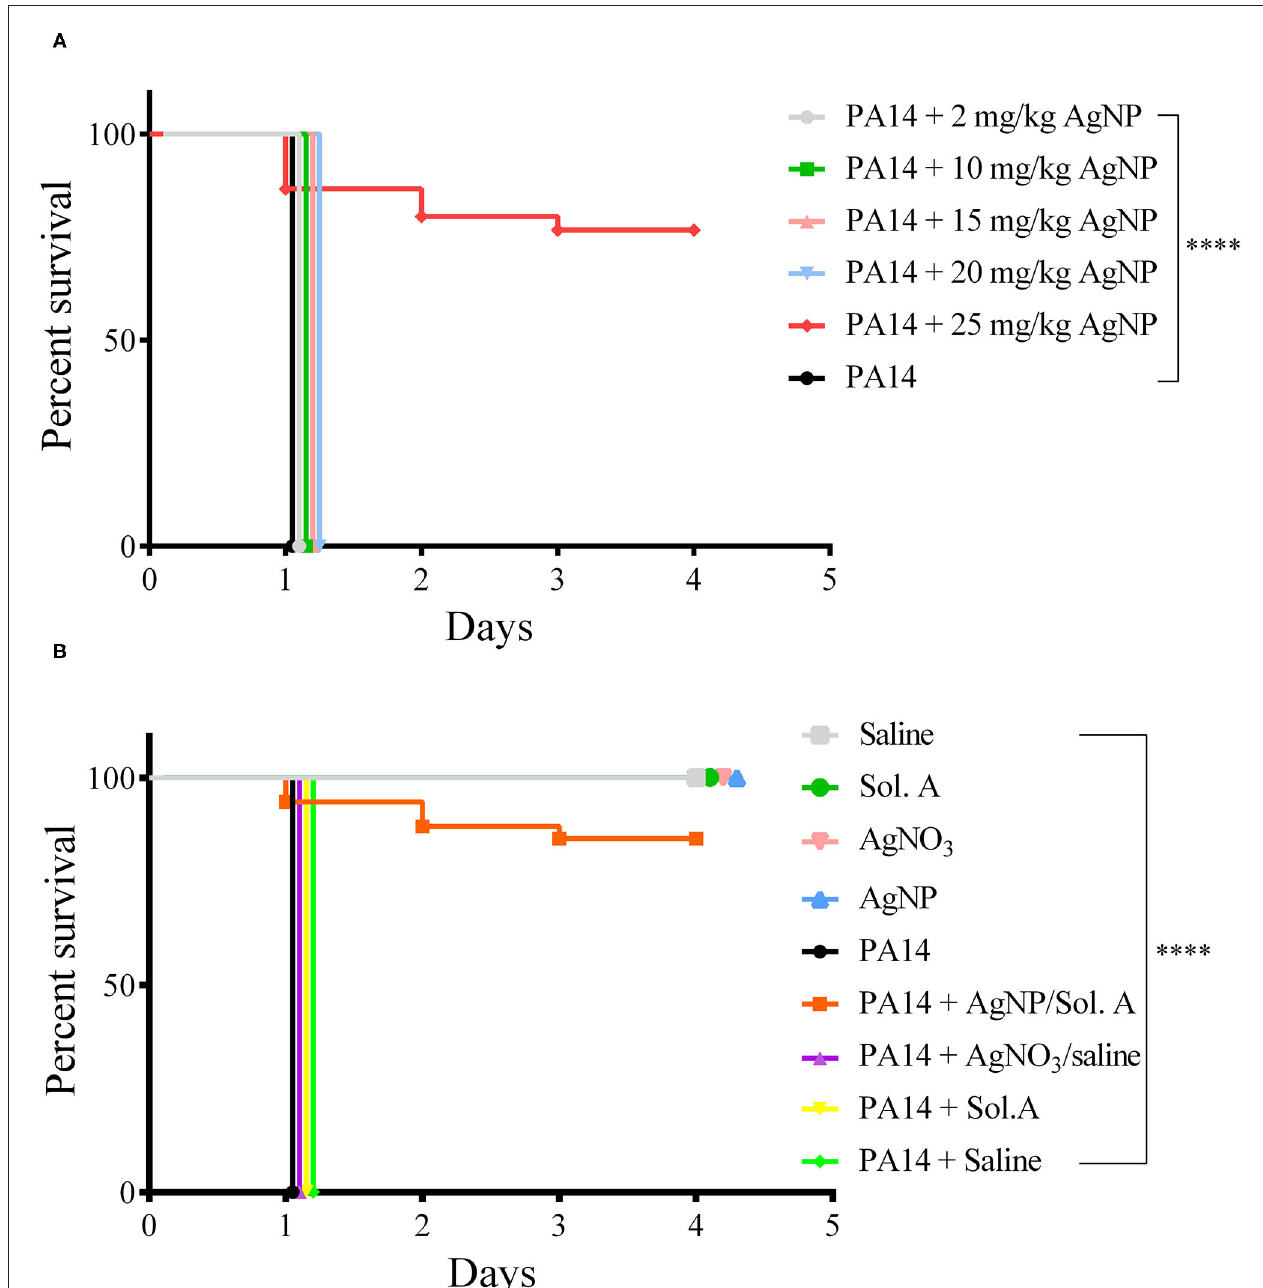
FIGURE 3 | Survival curves (Kaplan–Meier and Mantel Cox). (A) Protective effect of AgNPs in G. mellonella infected with P. aeruginosa . Groups of 20 larvae each were treated prophylactically for 2 h before infection, with 5–25 mg/Kg AgNPs per larva. The larvae were then infected with 100 CFU of P. aeruginosa strain PA14. The black line represents larvae infected with PA14 in the absence of any prophylactic treatment. (B) Groups of 20 larvae were prophylactically treated with 25 mg/Kg AgNPs, Solution A, Saline or AgNO 3 . Two hours later, they were infected with 100 P. aeruginosa cells. The control groups were: Saline (gray line); Sol. A (green); AgNO 3 (pink); AgNPs (blue). All larvae groups in A and B were incubated at 37 ℃ and their viability was followed for 4 days. Each line represents the mean of three independent experiments. **** p < 0.0001.